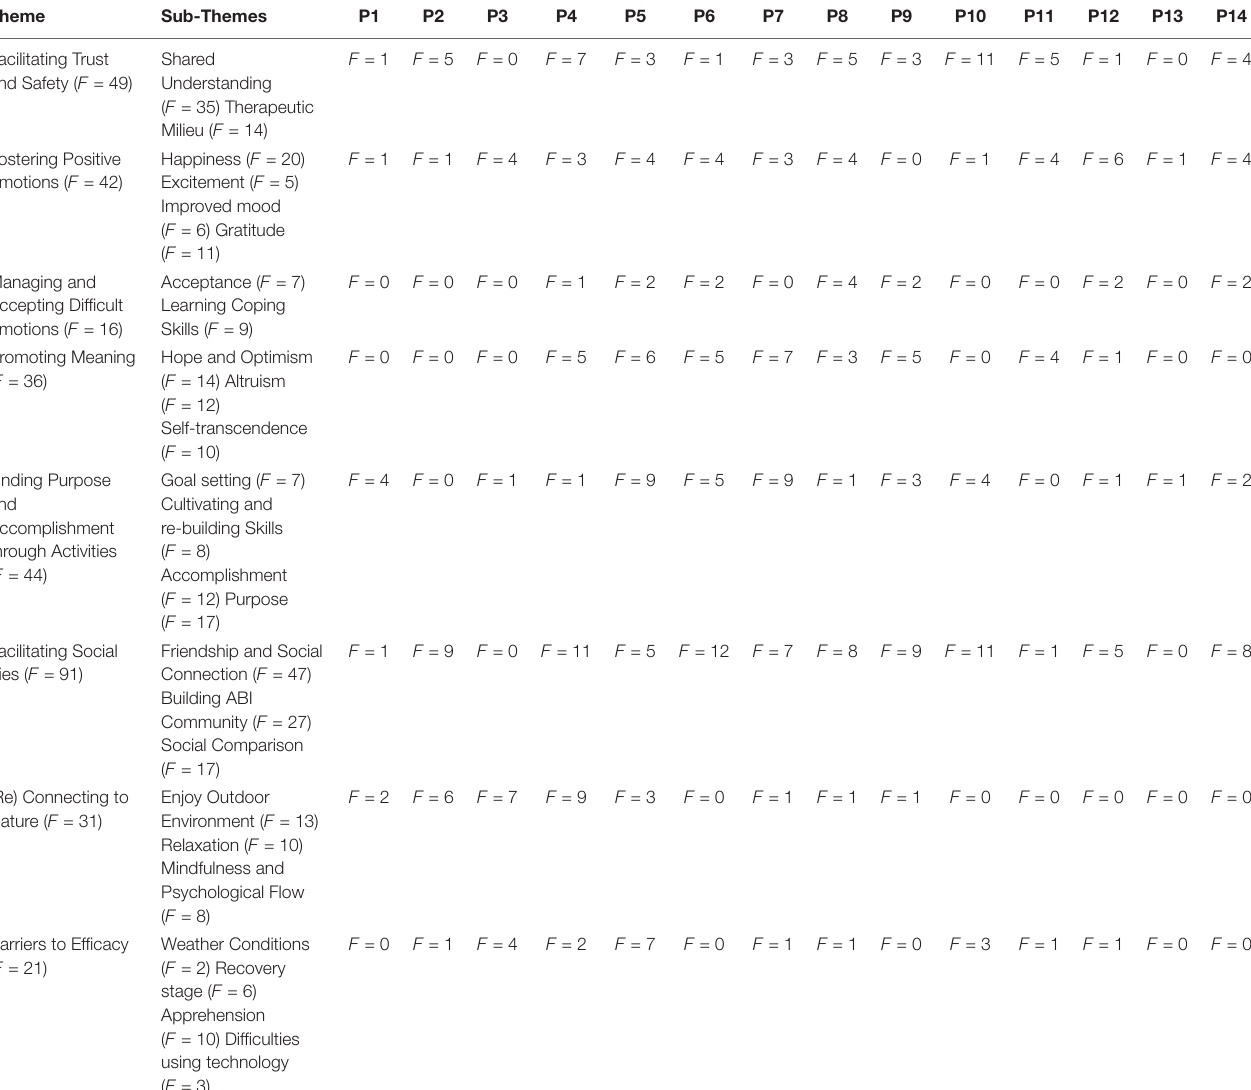
TABLE 4 | Themes and sub-themes identified from the transcripts. F , frequency of times theme is mentioned within the